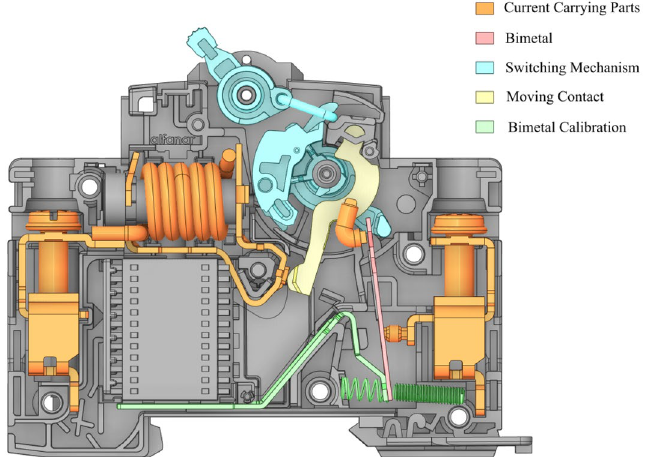
Figure 1. Illustration of the branch circuit breaker highlighting the bimetal, the switching mechanism, and the components used for calibration of the bimetal, genegrated using “ANSYS Spaceclaim R2 2021” 38 (https:// www. ansys. com/ produ cts/ 3d- design/ ansys- space